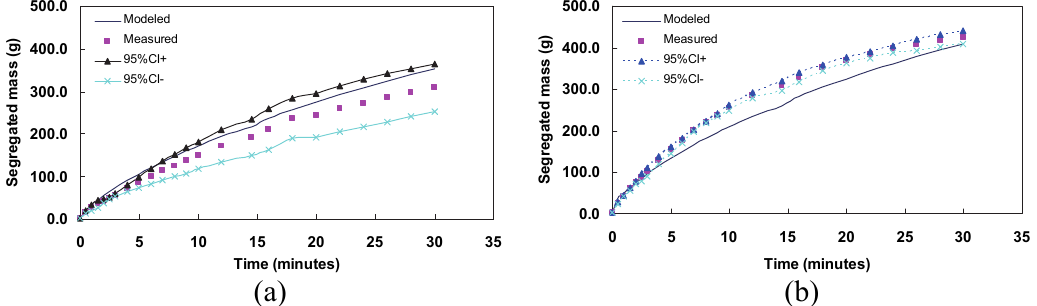
Fig. 4 Validation at strain rate of 0.5 Hz for size ratio 2.0:1.0 (a) potash-6%, and (b) potash-10%, 95%CI + and 95%CI- upper and lower limits of